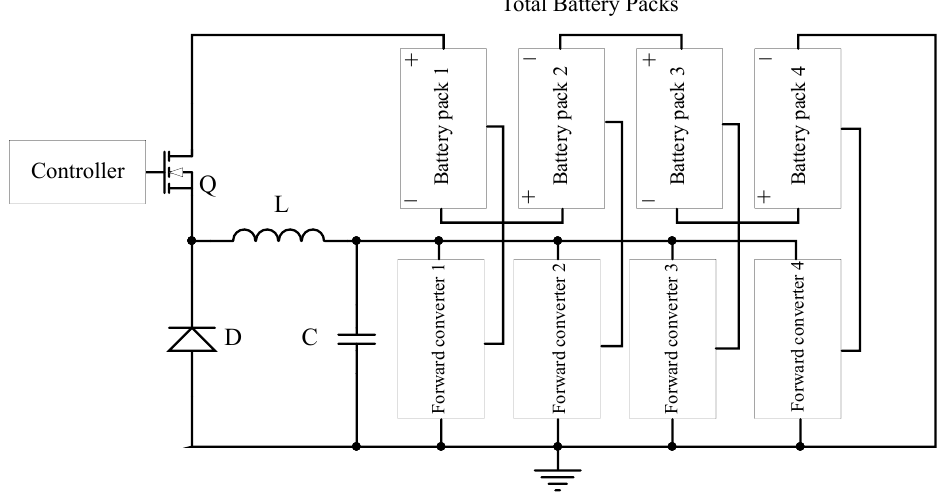
Figure 6. Schematic of the buck converter and forward